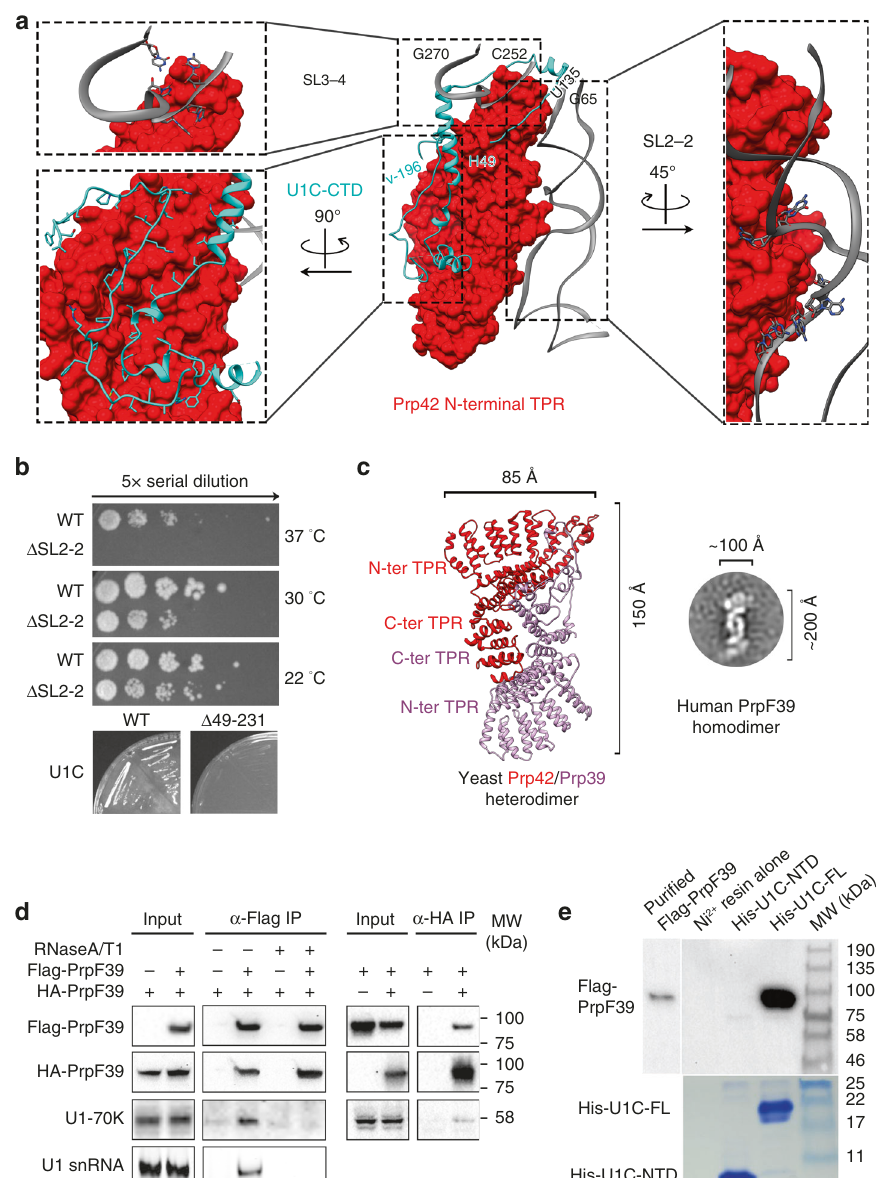
Fig. 4 Structures and interactions of yeast auxiliary proteins Prp42, Prp39, and human PrpF39. a The N-terminal TPR domain of Prp42 interacts extensively with the C-terminal domain of U1C, and to a lesser extent, with SL3-4 and SL2-2 of U1 snRNA. Details of the speci fi c residues involved in the Prp42-U1C interaction are presented in Supplementary Table 2. b Yeast strain carrying Δ SL2-2 shows slightly less robust growth than WT at 30 and 22 °C and is inviable at 37 °C. Yeast strain carrying U1C-CTD deletion is inviable when WT U1C is shuf fl ed out on a FOA plate. c Prp39 and Prp42 have a similar overall structure and interact with each other through their C-terminal TPR domains (left). A representative 2D class average of negative-stained images of puri fi ed human PrpF39 has dimensions and shape highly similar to the Prp42/Prp39 heterodimer (right). d Western blot and solution hybridization analyses demonstrate that IP using anti-HA antibody pulls down HA-PrpF39 and Flag-PrpF39 (with or without RNase A/T1 treatment), as well as human U1-70K and U1 snRNA (only in the absence of RNase A/T1 treatment) from HEK293 cells co-transfected with HA-PrpF39 and Flag-PrpF39 (left). Pull- down with anti-Flag antibody shows the same result (right, not treated with RNase or probed for U1 snRNA). e Pull-down using puri fi ed human U1C FL or NTD (residues 1 – 61) demonstrates that U1C FL but not the NTD binds to puri fi ed Flag-PrpF39. The top portion is a western blot using an anti-Flag antibody and the bottom is a SDS-PAGE gel stained with Coomassie blue to show U1C protein